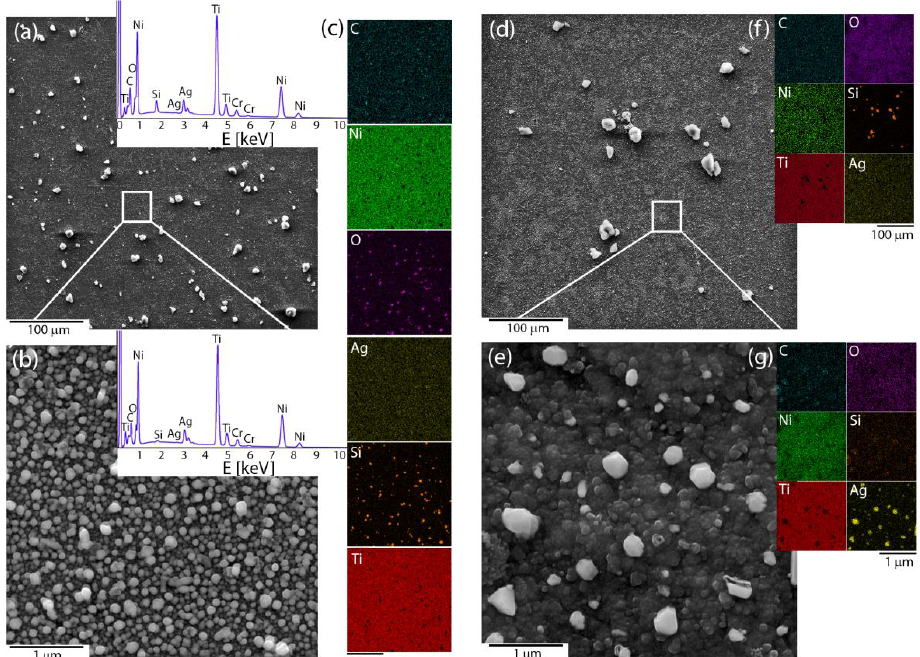
Figure 1. Microstructures of the ( a , b ) pristine and ( d , e ) sintered Ag-SiO 2 coating that was obtained based on the SEM images at two different scales, ( c , f , g ) chemical composition imaging of an indi- vidual elements. The EDS spectra from selected areas had a similar character for the pristine and sintered material. Table 1. Atomic percentage concentration of the individual elements of the coat-forming materials. Data originated from the modified NiTi alloy before and after sintering at 700 ◦ C per 2 h. The SEM-EDS should be considered to be a semi-qualitative method in this analysis. The data in brackets refers to the standard deviation data, which was obtained based on the measurements of the five different